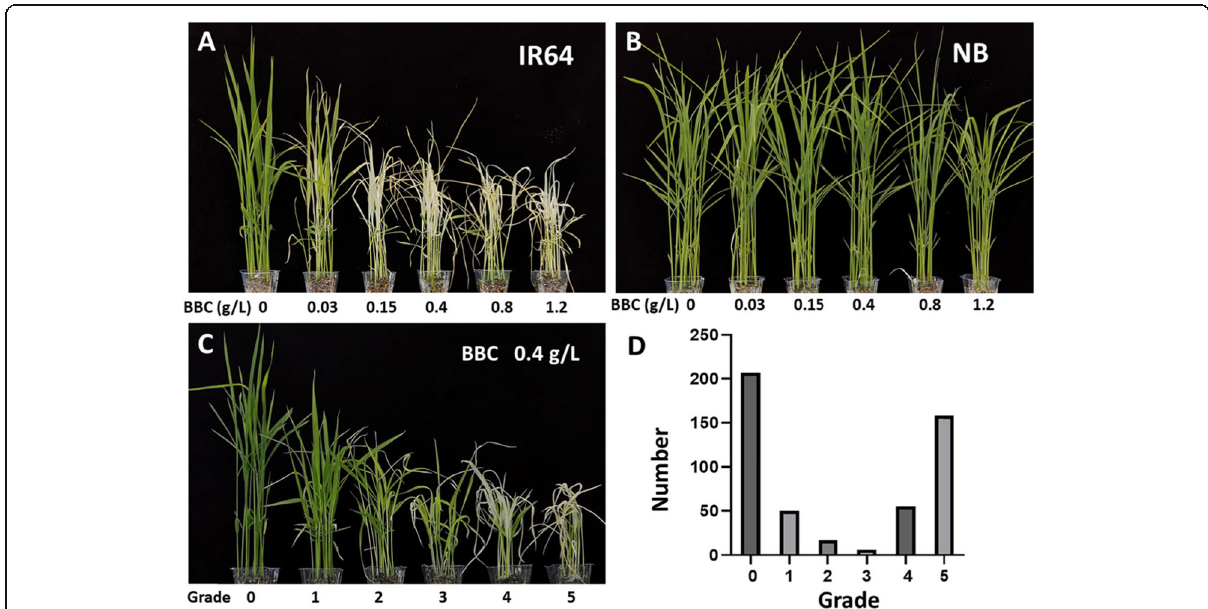
Fig. 1 Phenotyping of indica rice accessions. a Concentration-dependent effects of BBC on IR64. b Concentration-dependent effects of BBC on Nipponbare (NB). c Different graded phenotypes after treatment with 0.4 g/L BBC. d Number of accessions with different graded phenotypes. Grade 0: unaffected seedling; grade 1: seedling growth was slightly weakened; grade 2: seedlings with an obvious dwarfing phenomenon; grade 3: seedlings without obvious bleaching but where some had started to die; grade 4: seedlings bleached completely; grade 5: seedlings completely